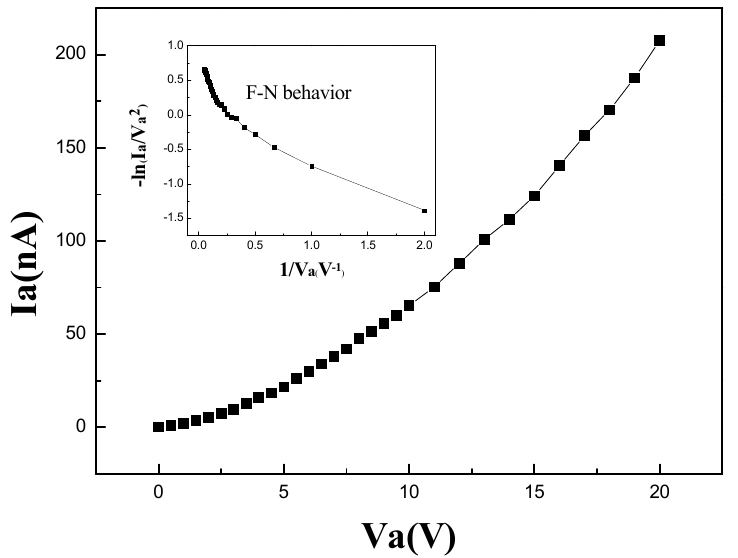
Figure 3. The anode current versus anode voltage curve of a diode at a bias voltage from 0 to 20 V. Inset: F–N plot for the I–V curve.